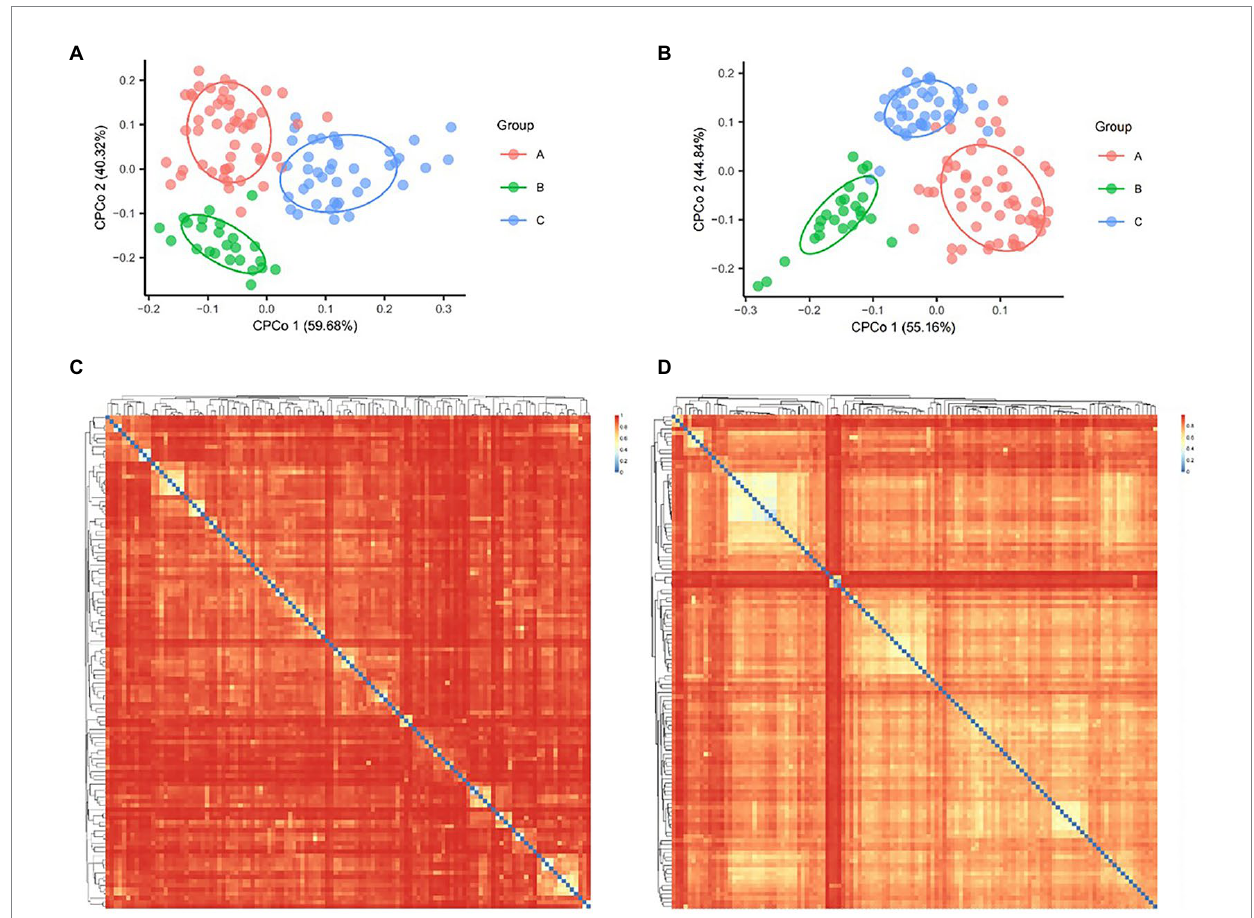
FIGURE. 1 Bacterial and fungal Constrained Principal Co-ordinates Analysis (CPCoA) according to Bray Curtis distance. (A) The diversity of bacteria showed 1.96% of variance according to Bray Curtis distance, p = 0.02. (B) The diversity of fungi showed 3.46% of variance according to Bray Curtis distance, p = 0.001. Heat map showed the Bray Curtis distance between bacterial (C) and fungal samples (D)